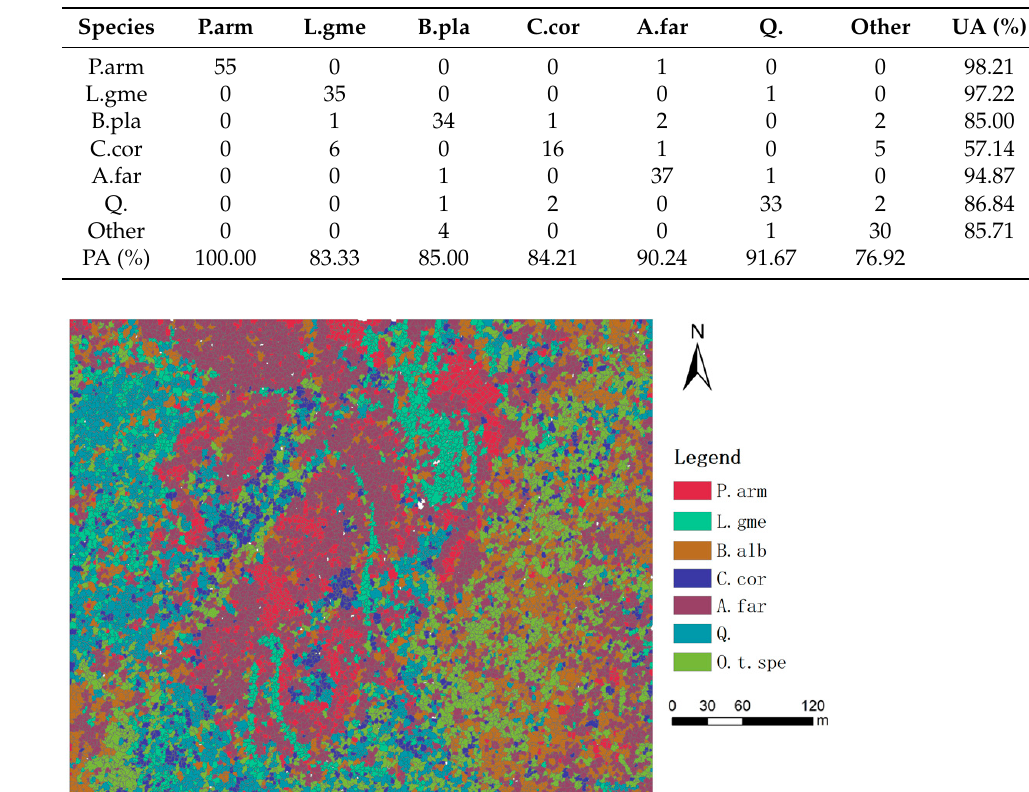
Figure 6. Classification results of tree species at altitude 1800 m based on XGBoost.